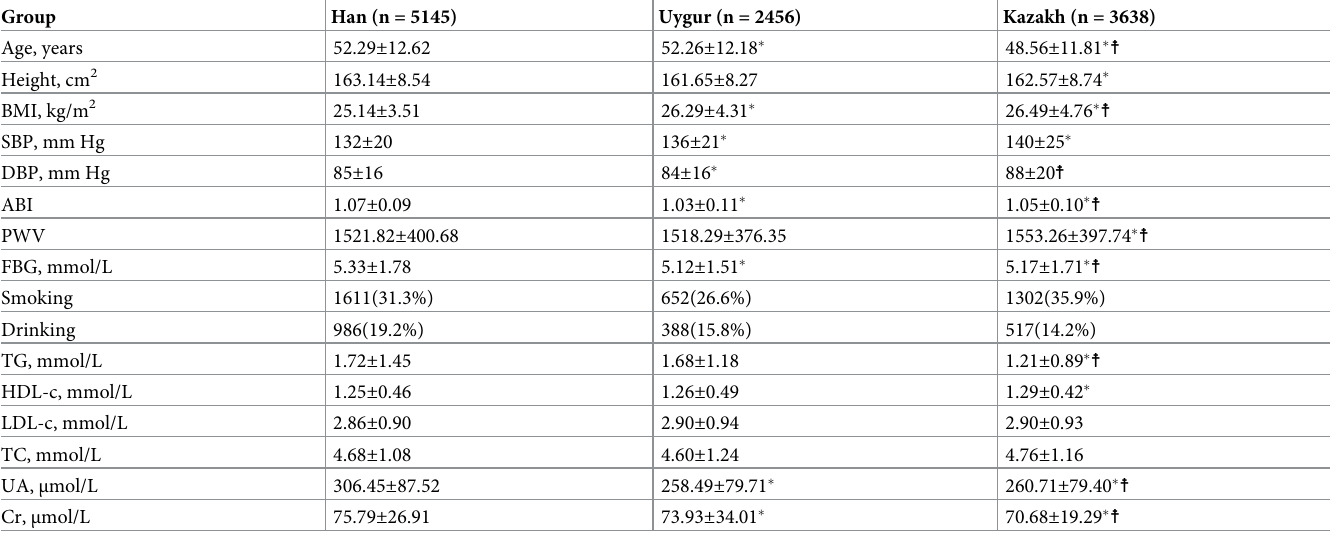
Table 1. General characteristics of study